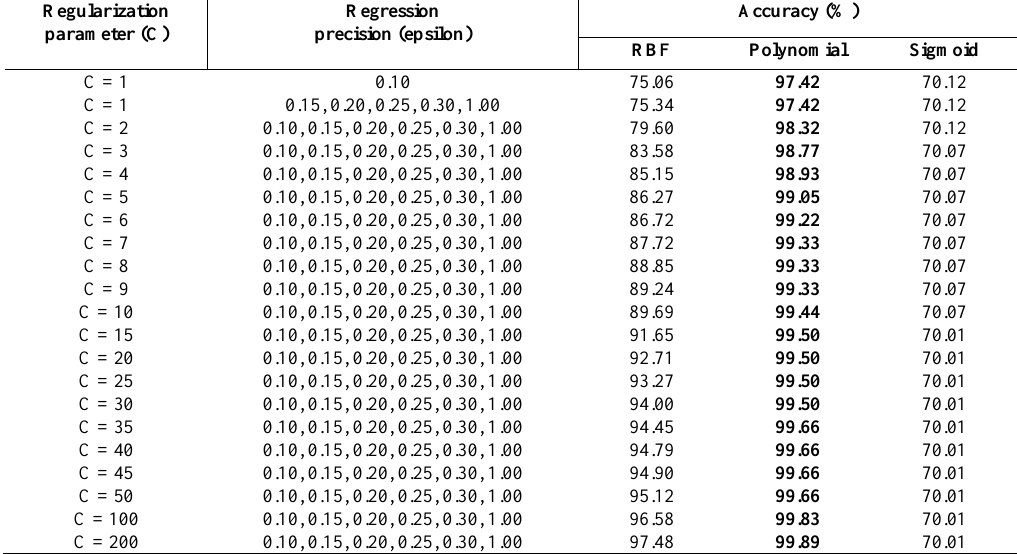
Table 7. Parameter validation with different C values in SVM algorithm on